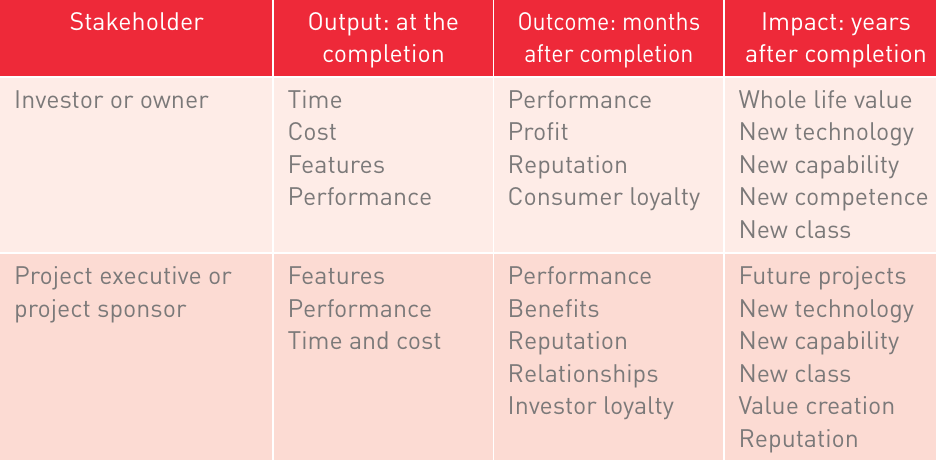
Project success understood by time frame Stakeholder Output: at